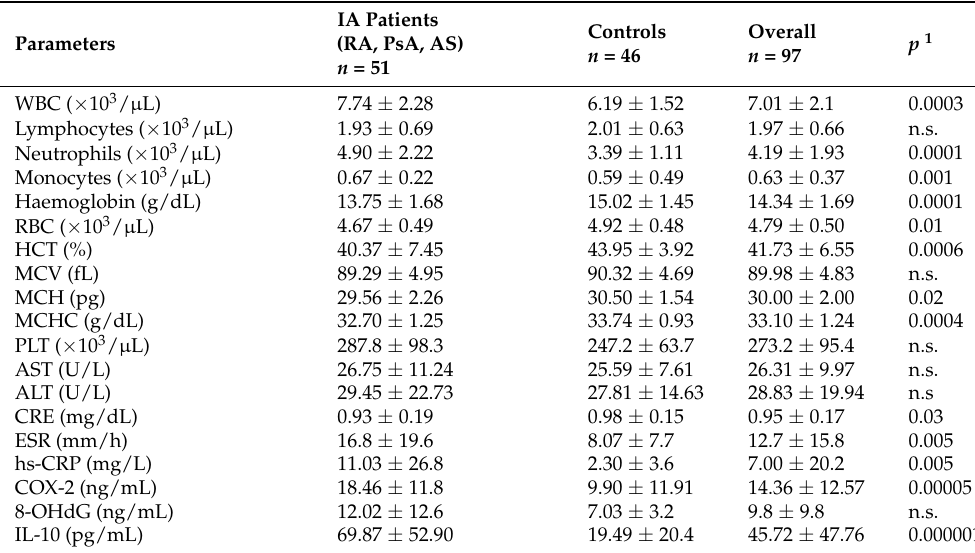
Table 2. Laboratory parameters of IA patients and controls (mean ± SD).